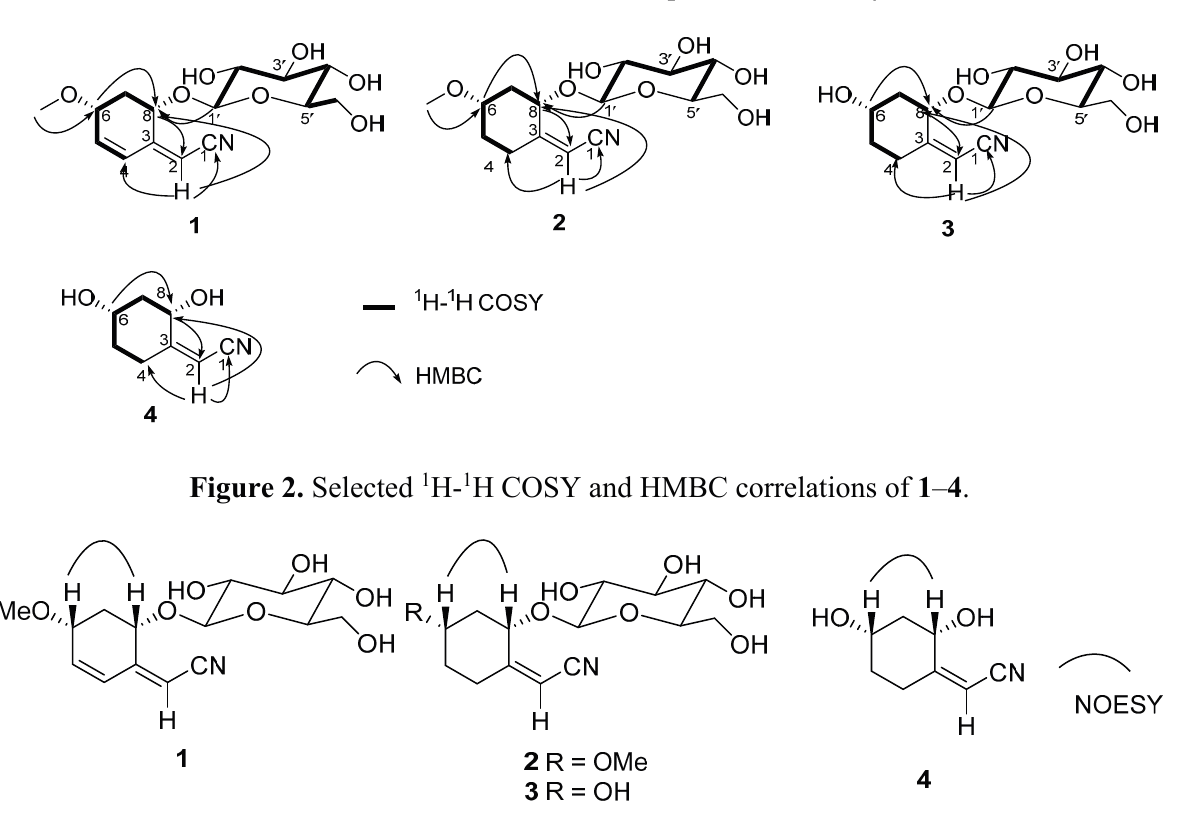
Figure 3. Selected NOESY correlations of 1 – 4